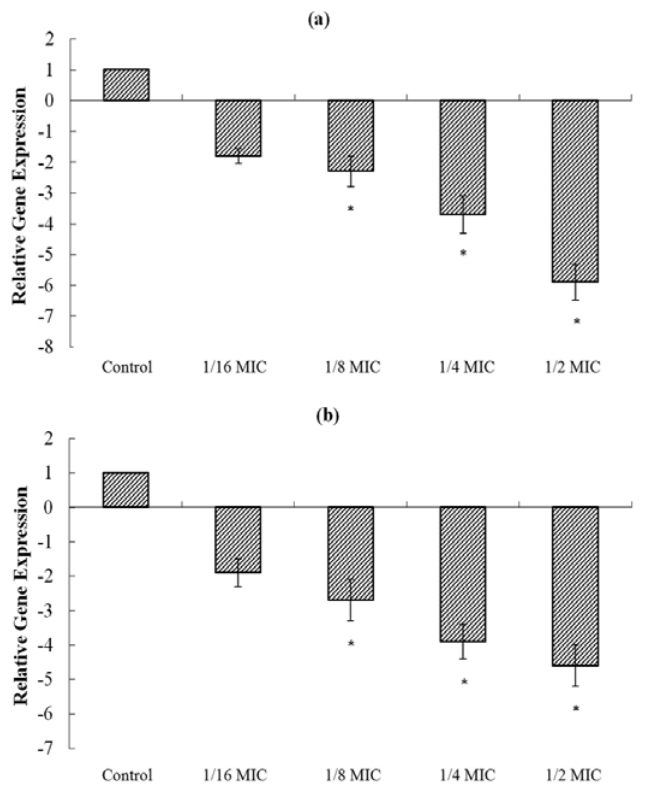
Figure 5. Relative gene expression of hla in strain ATCC 29213 (a) and MRSA strain 3701 (b) after growth with sub-inhibitory concentrations of magnolol. Values represent the mean and standard error of three independent experiments. * represents p <